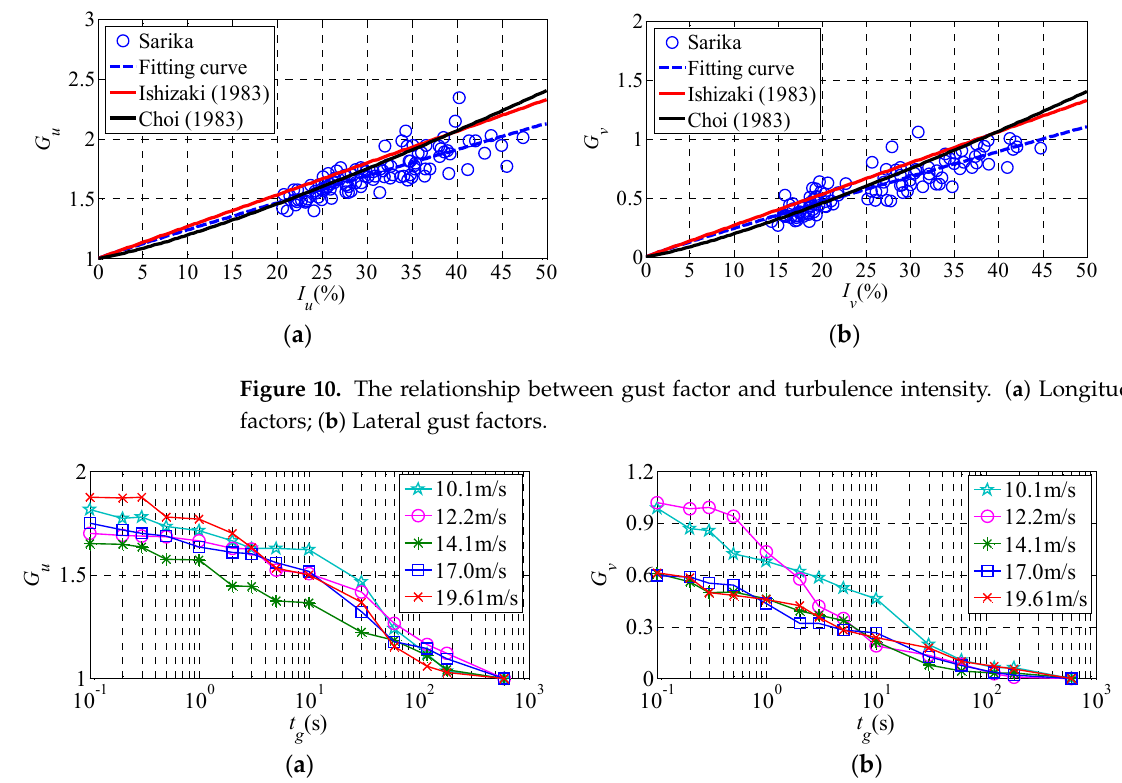
Figure 9. The variation of gust factor with respect to 10-min wind speed and direction. ( a ) G u with respect to 10-min U ; ( b ) G v with respect to 10-min α .